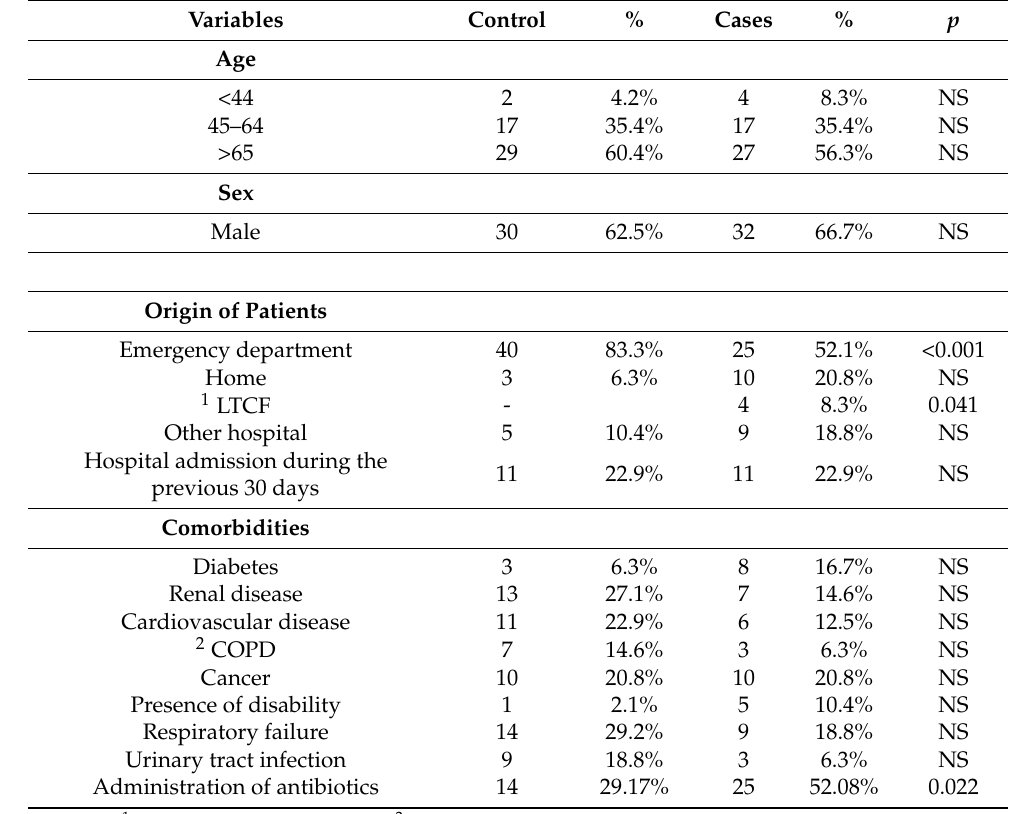
Table 2. Distribution of selected variables associated with the detection of CPE on